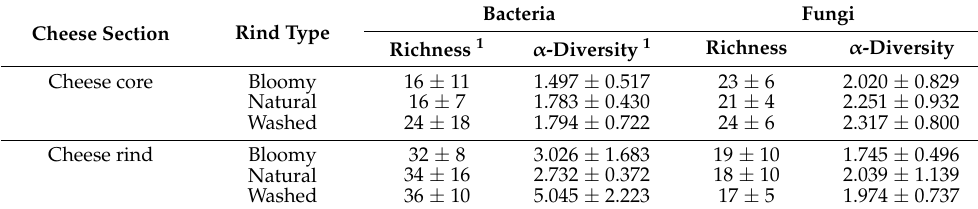
Table 2. Richness and α -diversity of cheese